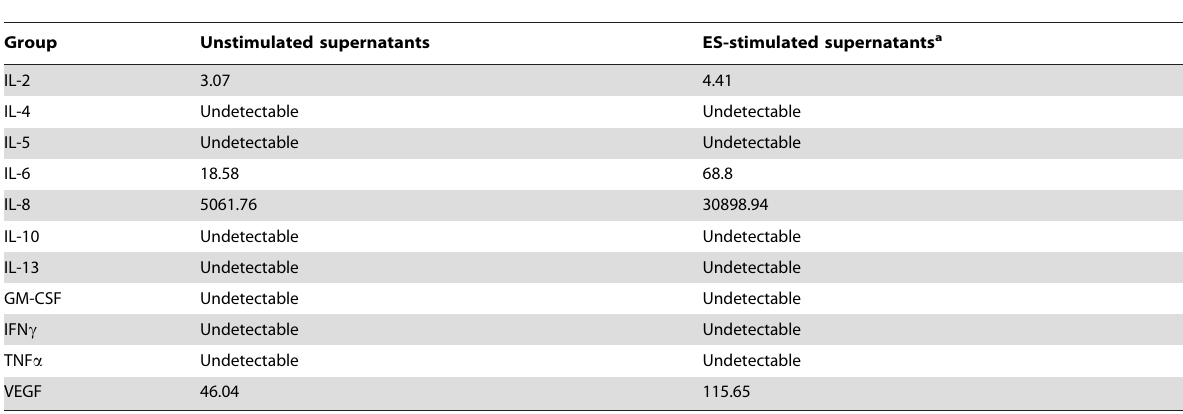
Table 1. Cytokine and growth factor levels (pg/mL) in PBMC supernatants a .